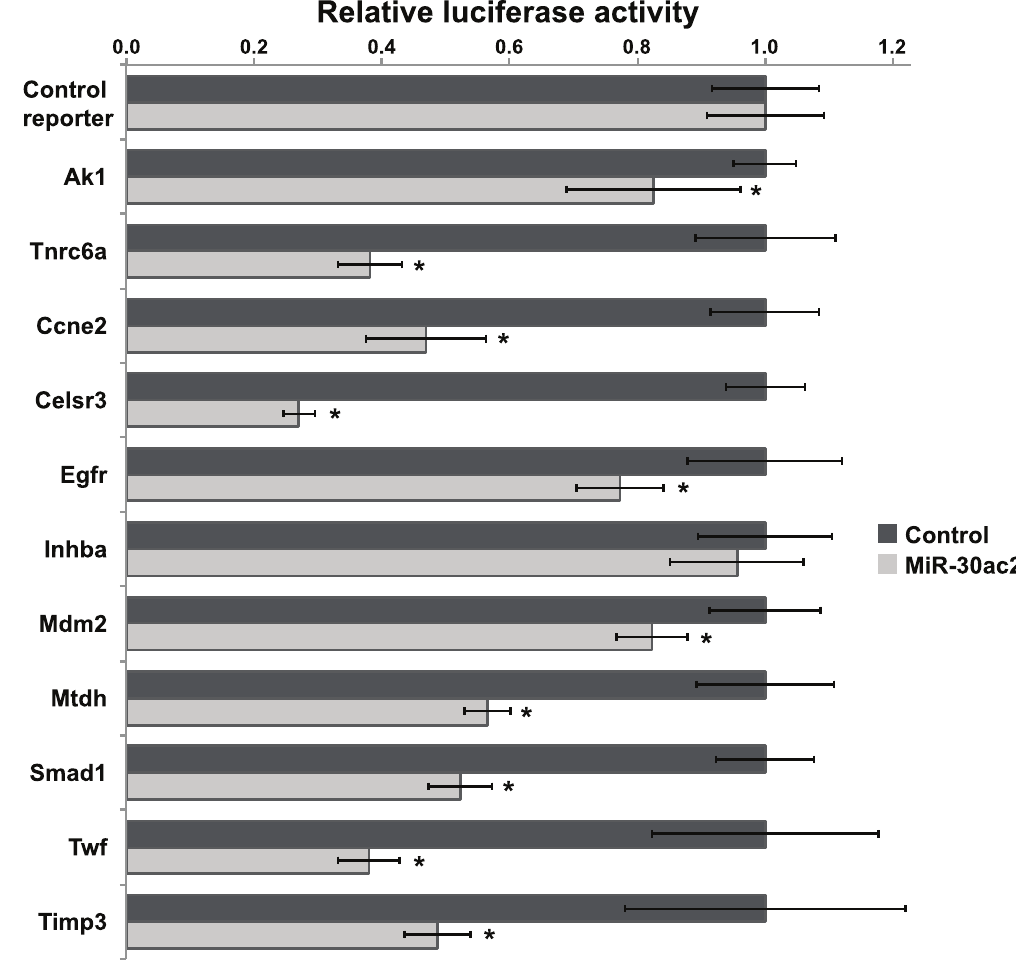
Figure 2. Confirmation of miR-30ac2 target genes. HEK293T cells we transfected with the miR-30ac2 expression plasmid and the indicated reporter plasmids. The ratio of firefly to Renilla luciferase activity for each reporter was normalized to that of an empty reporter. Error bars indicate the standard error of the mean. * p < 0.05. The data represent three separate transfections, each with three technical replicate